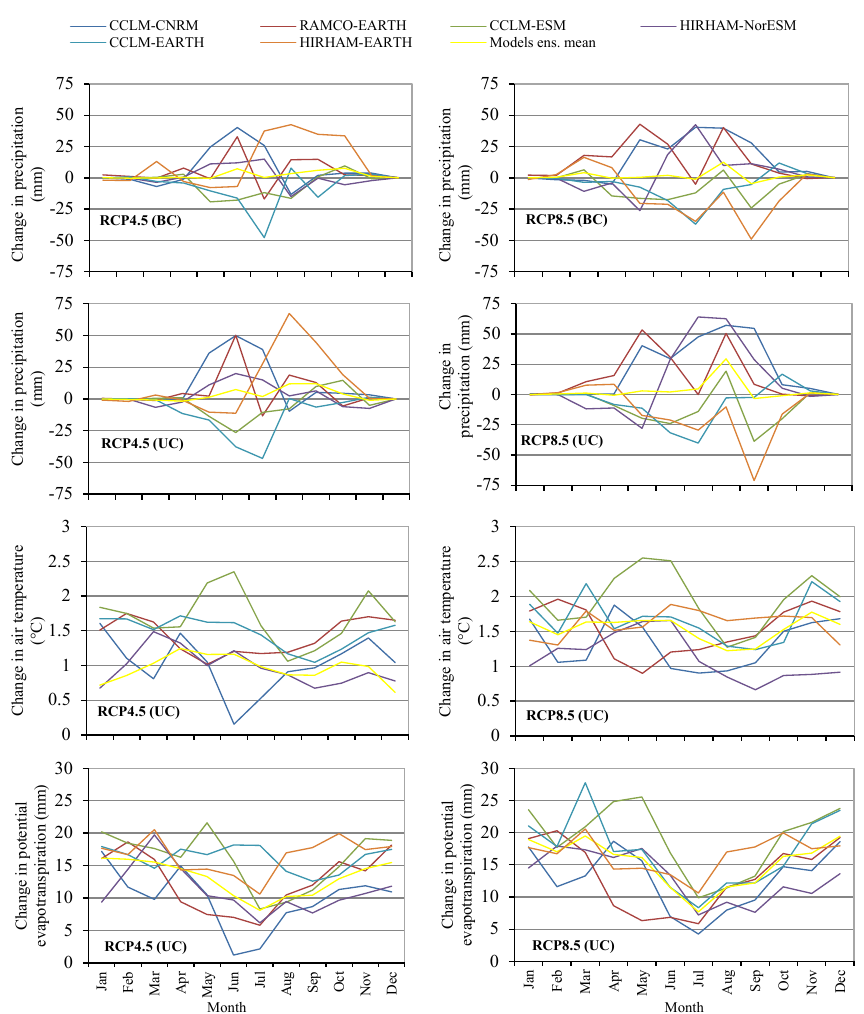
Figure 6. Climate change signal of precipitation, air temperature, and evapotranspiration between the reference (1971–2000) and fu- ture (2021–20150) periods under emission scenarios RCP4.5 and RCP8.5. BC is bias corrected and UC refers to non bias